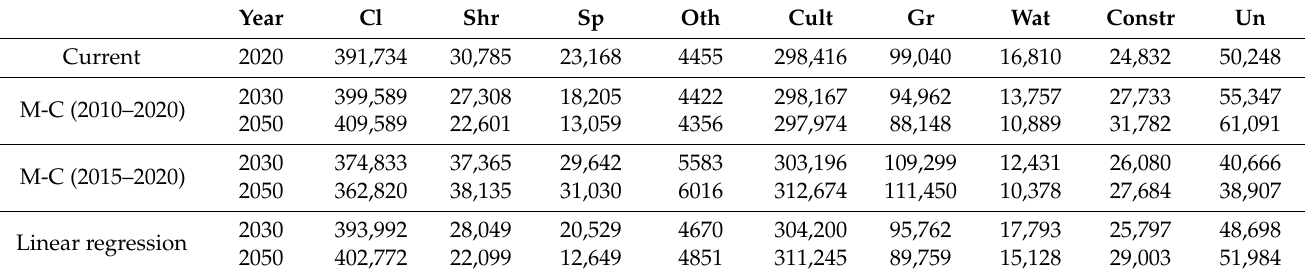
Table 4. Predicted area of land calculated by Markov chain and linear regression (km 2 ).